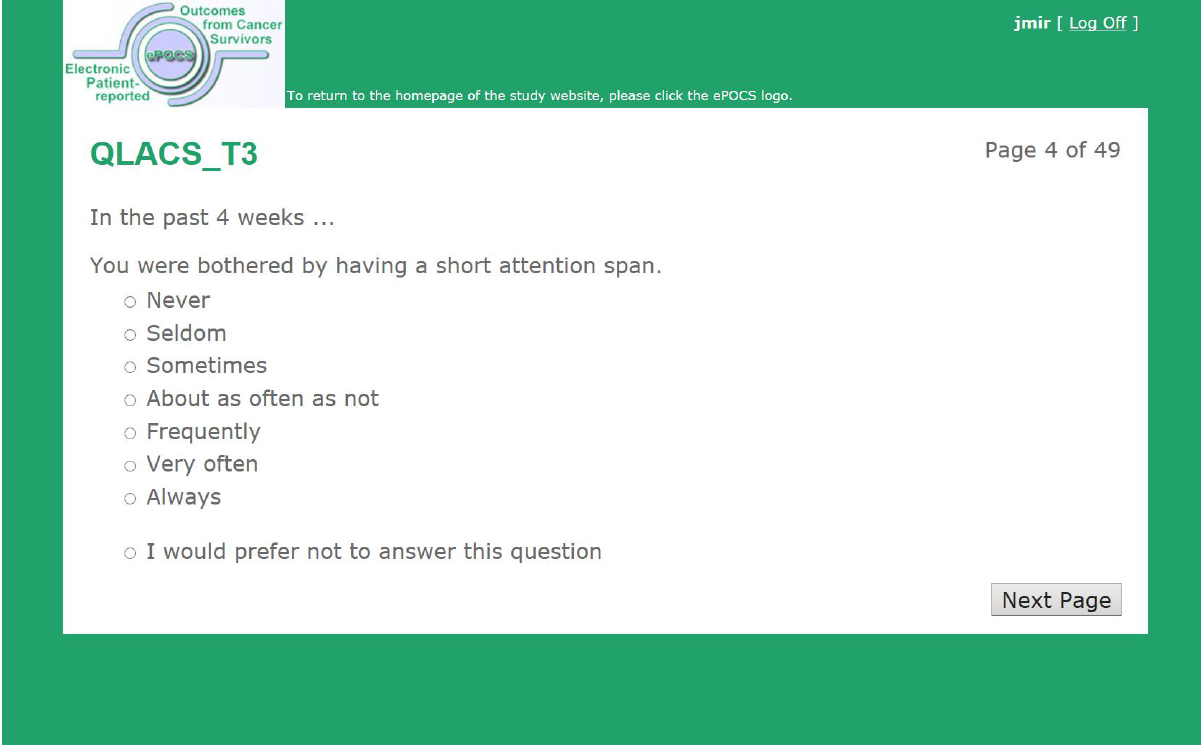
Figure 4. Screenshot of an ePOCS system questionnaire item (item 3 from the 47-item Quality of Life in Adult Cancer Survivors